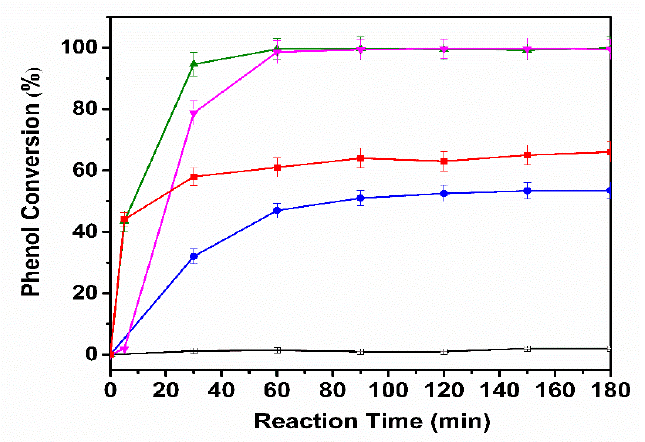
Figure 16. Evolution of the phenol concentration as a function of time upon the CWAO of